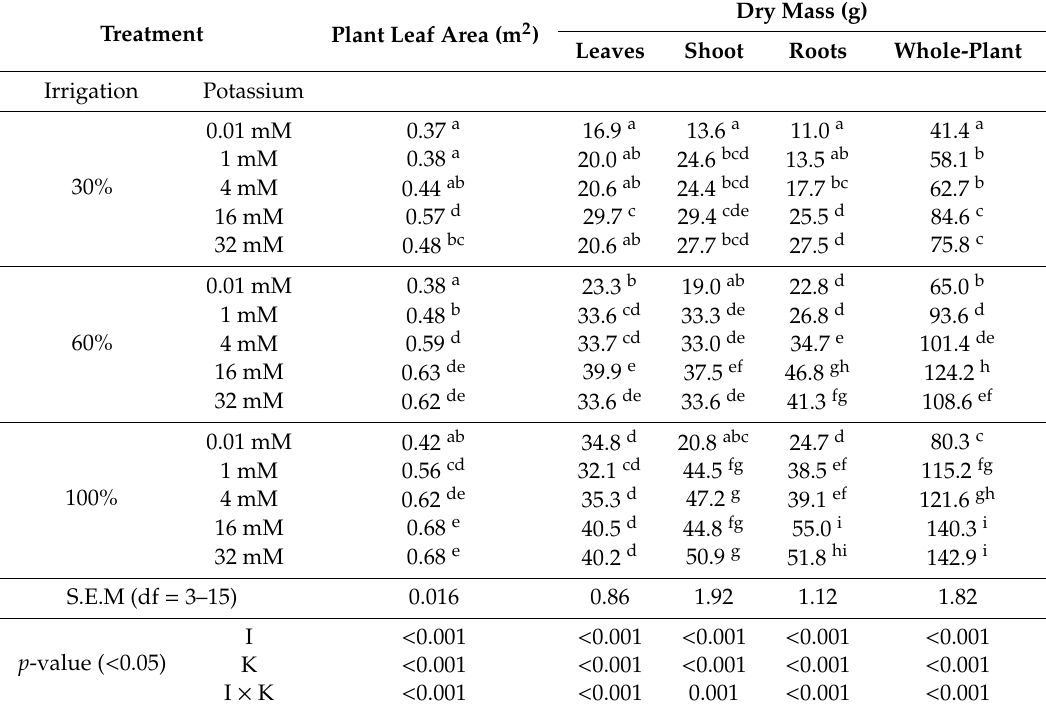
Table 2. Plant leaf area, leaf dry mass, shoot dry mass, root dry mass, and whole-plant dry mass of 90-day-old cassava plants in four pot experiments. Deficit irrigation and K fertigation were initiated 30 days after planting and lasted 60 days. The data from separate experiments were combined and shown as the means of 4 to 16 replicate plants. Dry Mass (g) Treatment Plant Leaf Area (m 2 ) Leaves Shoot Roots